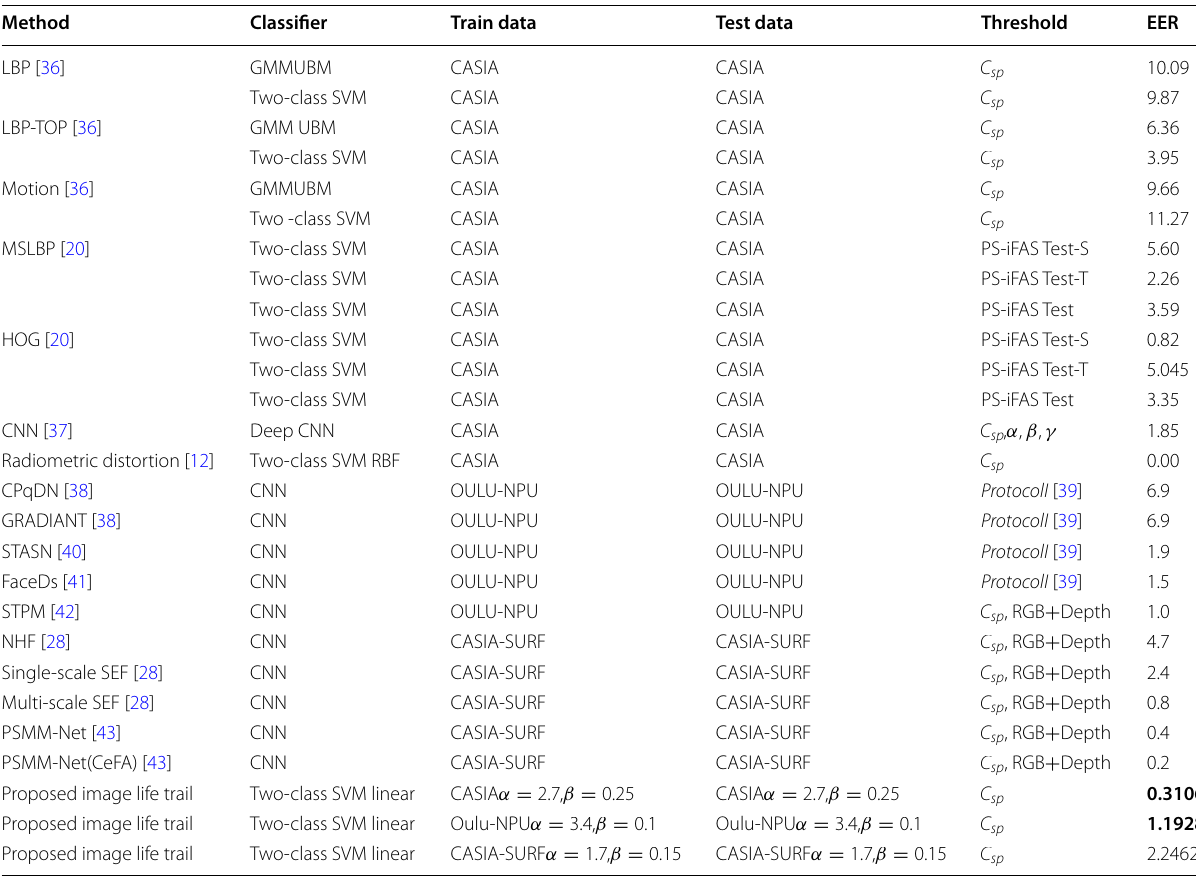
Table 4 State of the art methods within a client specific frame. C sp : represents the subject-specific or client specific mode of training and testing; in Protocol I below used on the OULU set, the same C sp mode has been −